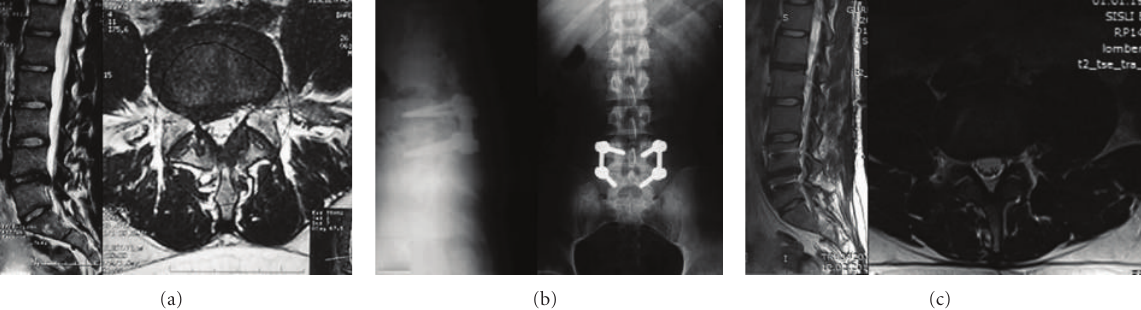
Figure 13: 18-year-old, male patient with severe acute back pain attacks. In the last attack, he became aware of sciatalgia on the right side. He had no response to medical treatment and physical therapy; he had di ffi culties in daily life. (a) Preoperative MRI showed posterior annular defects, and a bulging disc to the right L5 nerve root is compressed; (b) saphinas system was applied; (c) one year after surgery the patient is very satisfied with this surgery, and MRI showed no bulging or defects of posterior annulus.